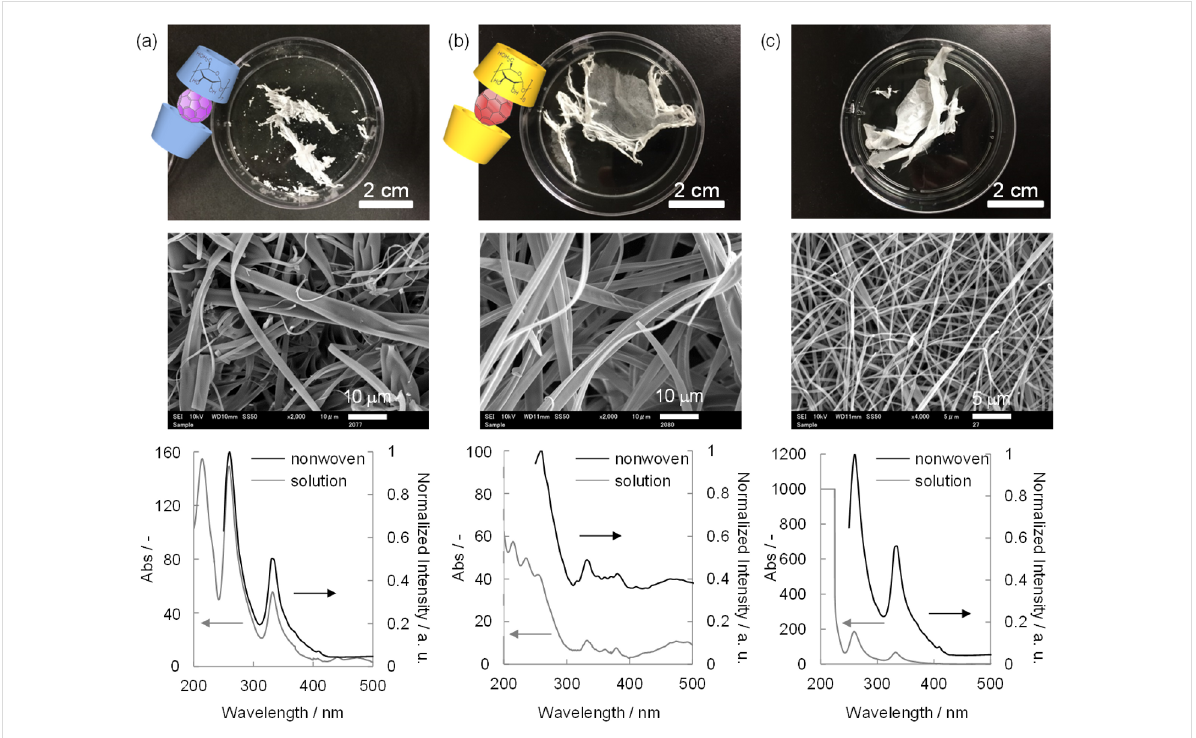
Figure 4: Extended variation of CD–fullerene inclusion complex to fabricate supramolecular solid functional fibers by electrospinning. Photographs, SEM images, and UV–vis absorption (solutions)/diffuse reflectance (nonwovens) spectra of (a) β -CD–C 60 and (b) γ -CD–C 70 . (c) Embedding of molec- ularly-dispersed C 60 into a gelatin matrix by simply mixing gelatin and the γ -CD–C 60